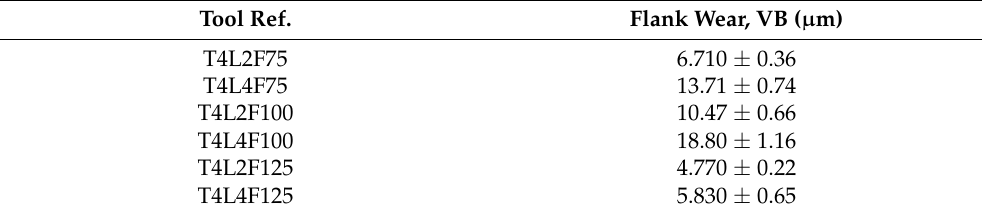
Table 15. VB values obtained from measurements performed on the clearance faces of T4 tools. Tool